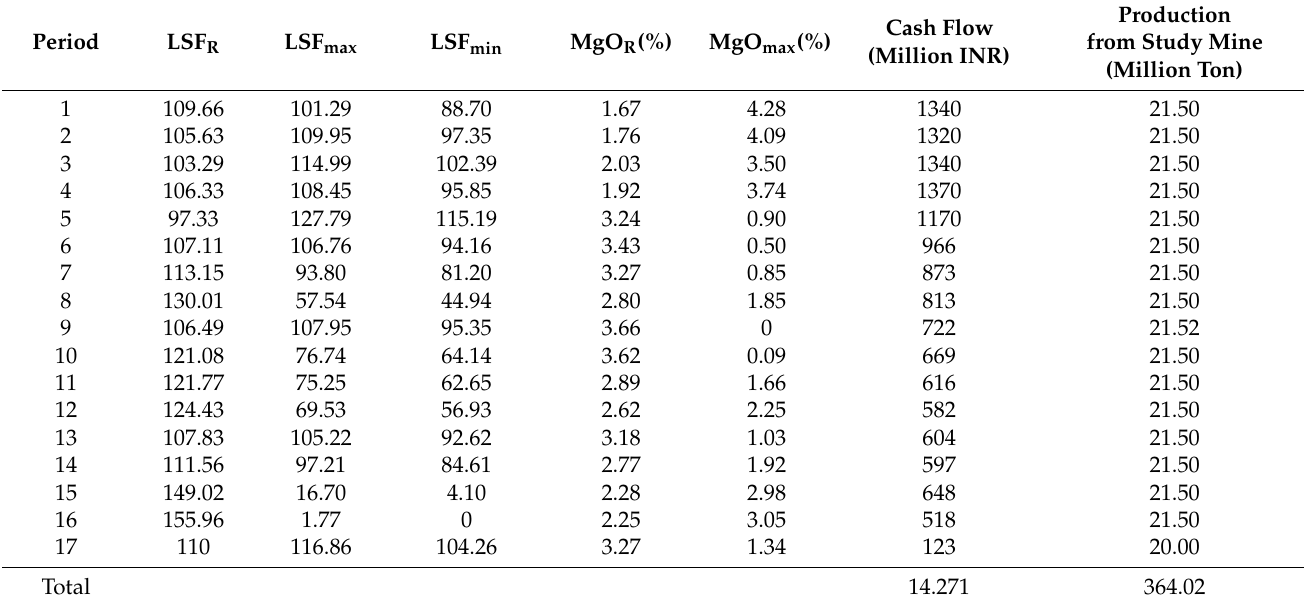
Table 3. Production scheduling results of Model 2.